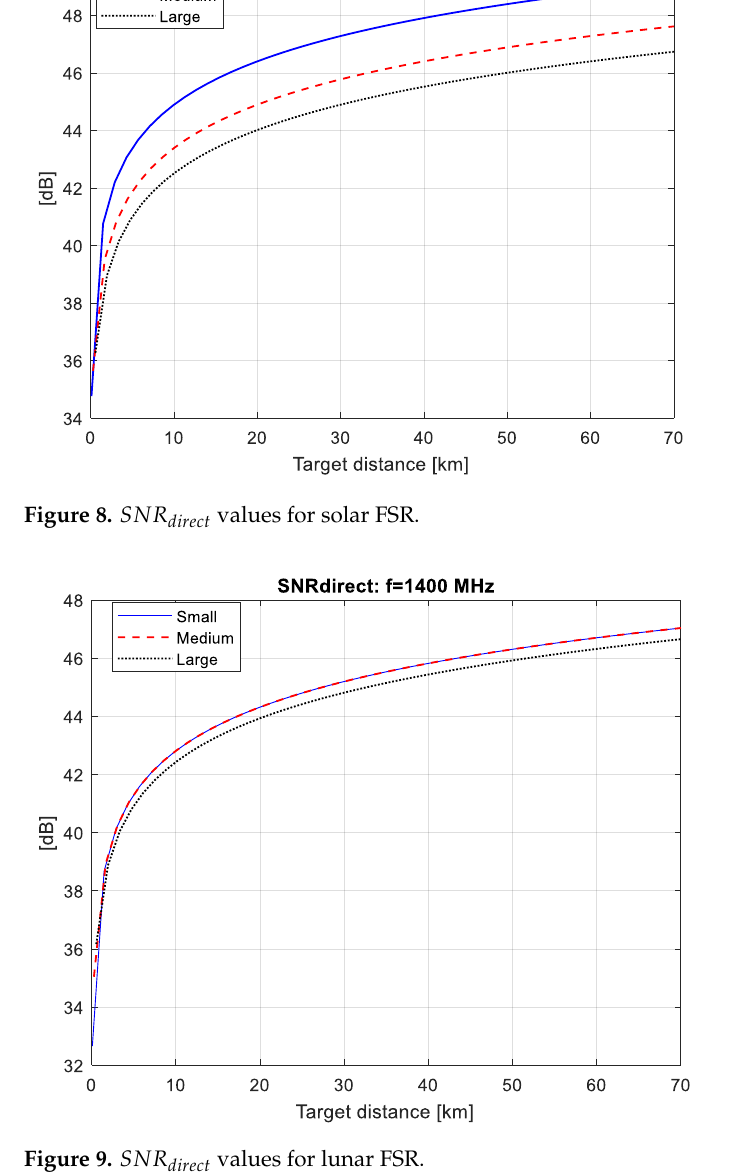
Figure 10. Probability of detection for various 𝑃 𝑓𝑎 .